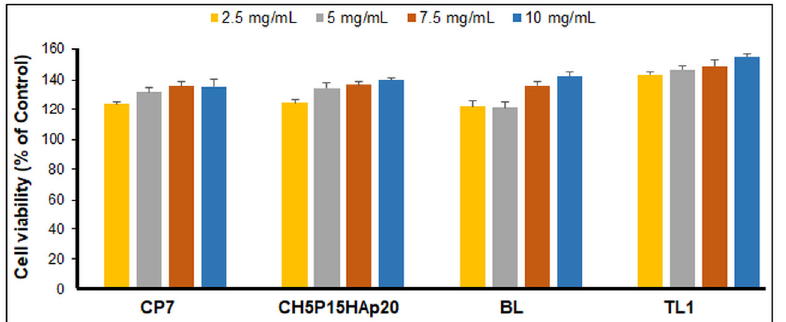
Figure 10. Cell viability of normal fibroblasts exposed to different samples’ extracts at various concentrations in complete cell culture medium (2.5 mg/mL, 5 mg/mL, 7.5 mg/mL, and 10 mg/mL) for 24 h.